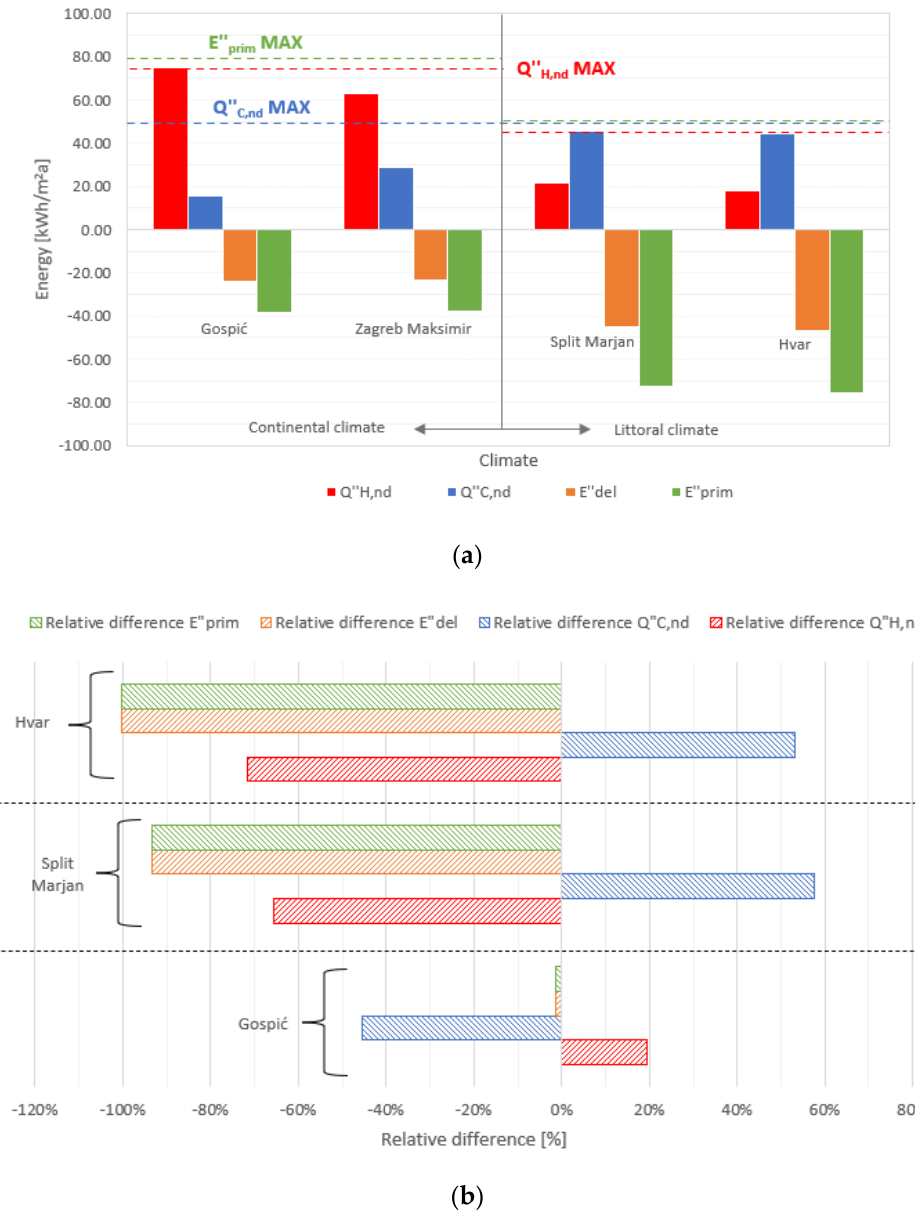
Figure 13. MUZA energy performance: ( a ) in different locations for southern orientation of the main façade; ( b ) relative differences in respect to the Zagreb Maksimir climate.